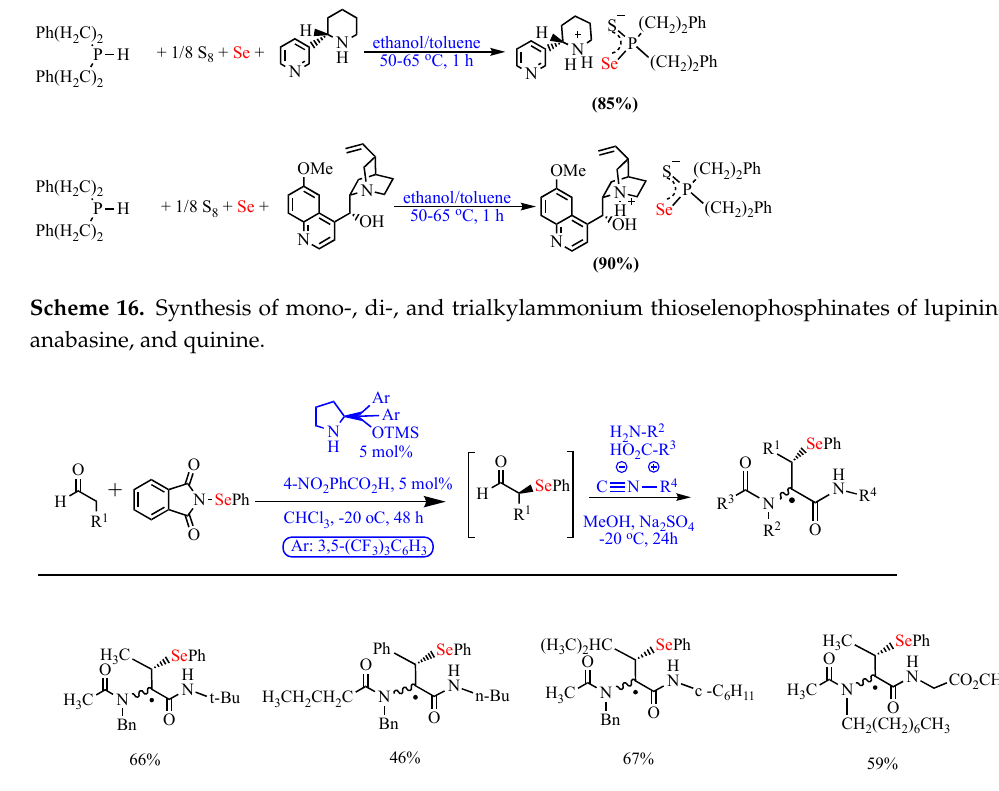
Scheme 17. Synthesis of selenocysteine-based peptoids and peptide–peptoid